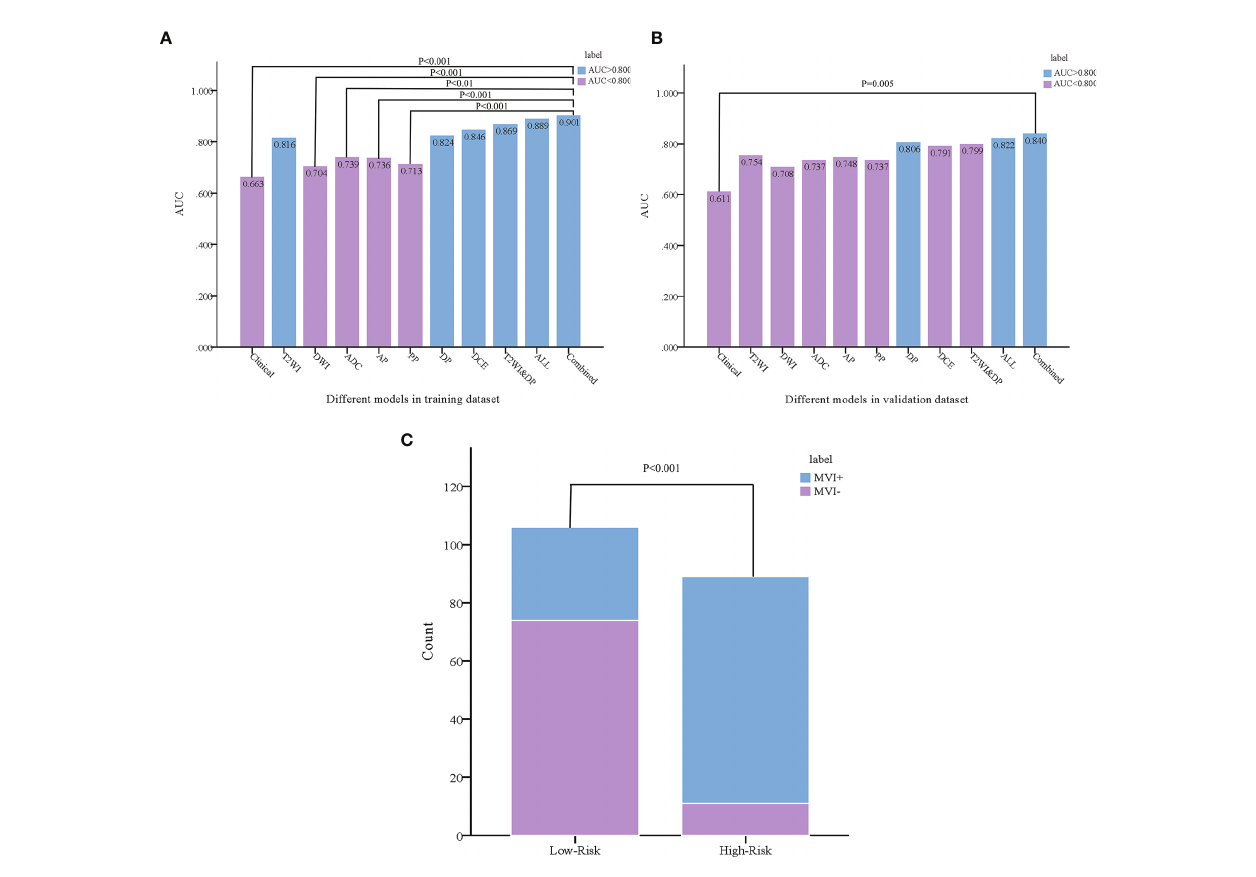
FIGURE 4 | Comparison was made between the combined model and the other models using the Delong test in the training (A) and validation (B) datasets. According to the combined model, the probability of microvascular invasion in the high-risk group was signi fi cantly higher than that in the low-risk group (C)